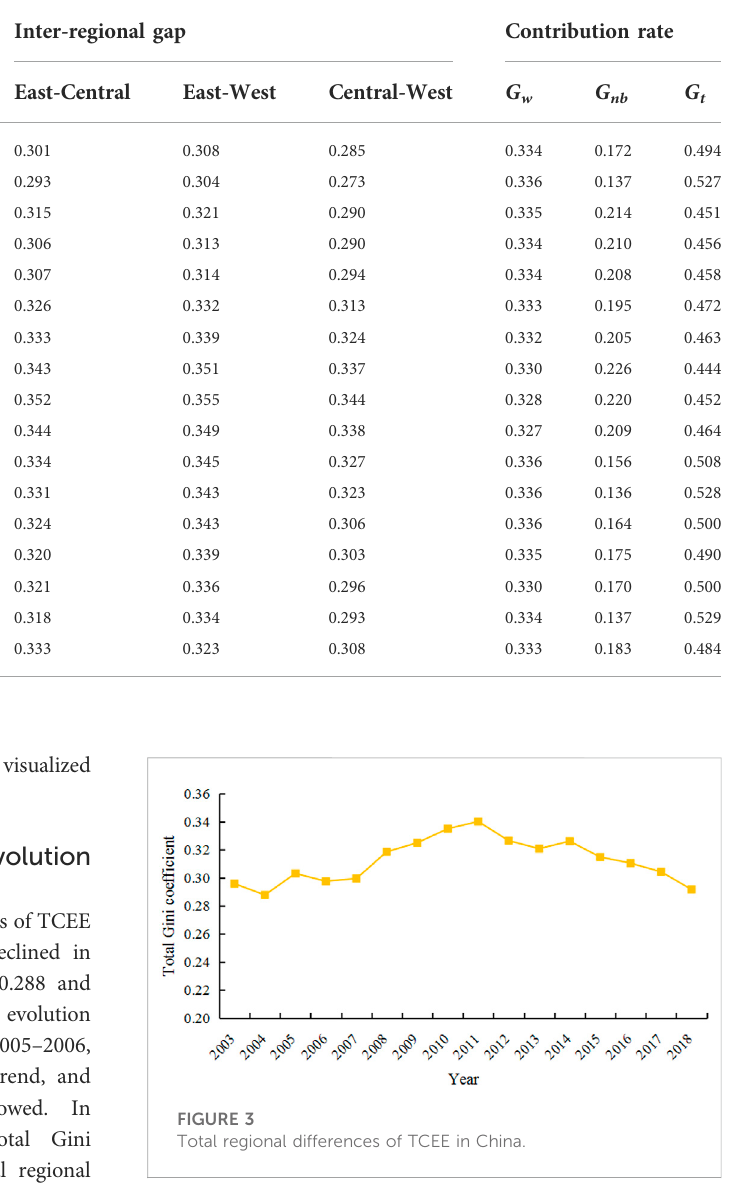
TABLE 3 Gini coef fi cient and decomposition of TCEE in China.